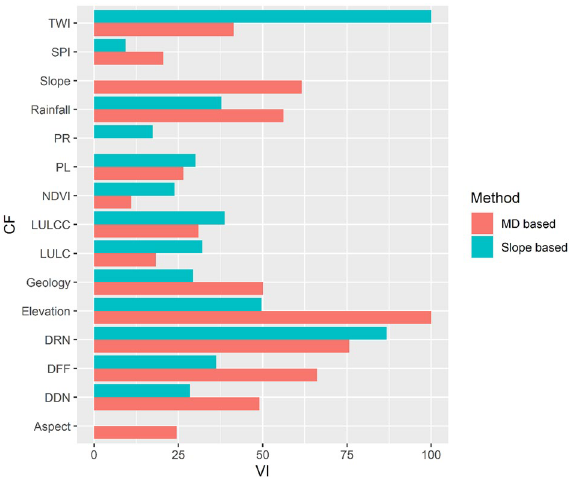
Figure 8. Variable importance plot of random forest model. CF causal factors, VI variable importance, PR profile curvature, PL plan curvature, LULCC land use/land cover change, LULC land use/land cover, DRN distance from road network, DFF distance from fault lines, DDN distance from drainage